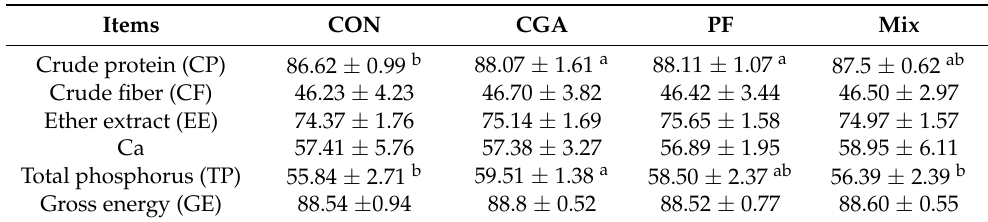
Table 5. Effect of crude extract of honeysuckle and Pueraria lobata root on the apparent digestibility of nutrients in finishing pigs.